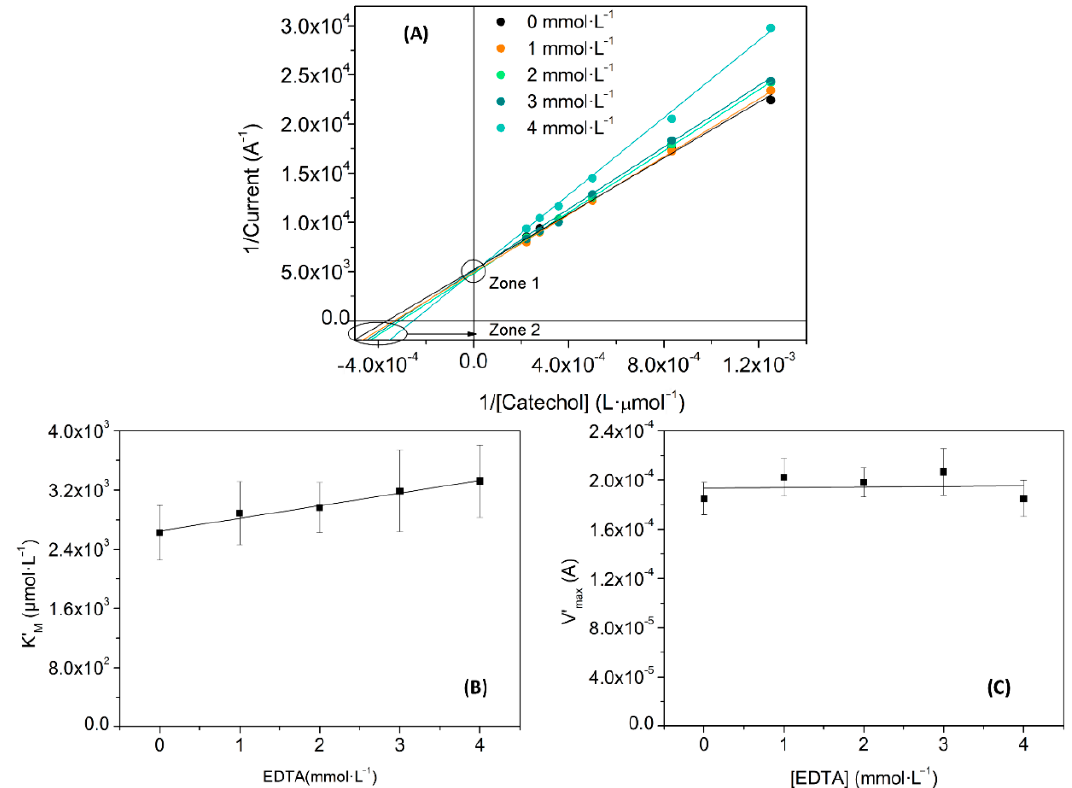
Figure 10. Biosensors kinetic study, ( A ) Lineweaver–Burk linearization for four benzoic acid concentrations; ( B ) represen- tation of the obtained K’ M values for each inhibitor concentration; and ( C ) V’ max obtained values for each inhibitor concen- tration.